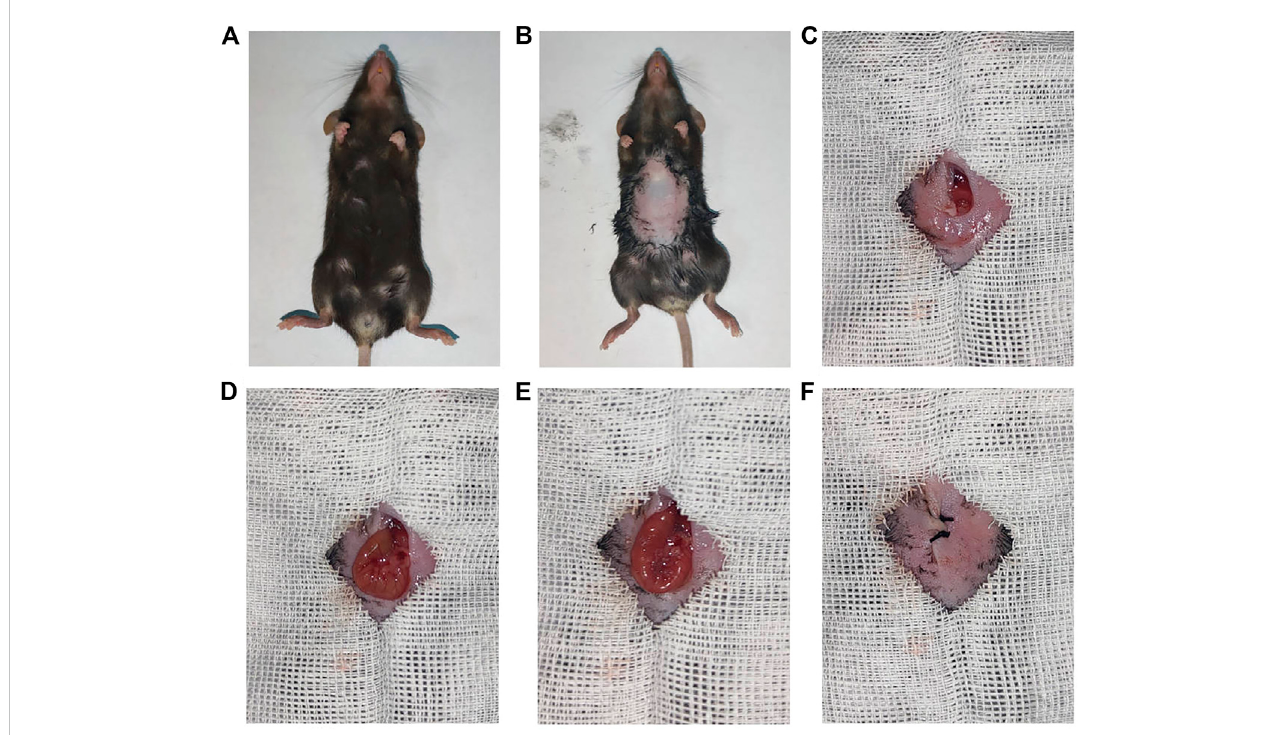
Procedure of β -cell-encapsulated microcapsules transplanted to the mesentery. (A,B) General pictures of a mouse. (C – F) Intraperitoneal delivery of microcapsules to the mouse with diabetes.